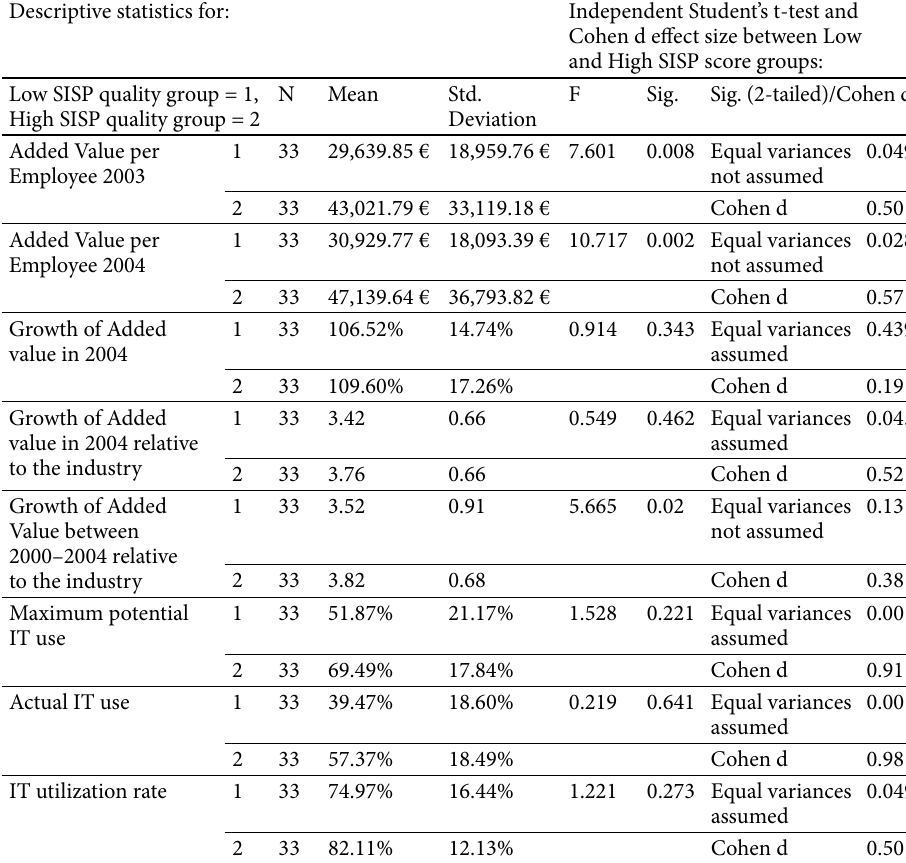
Table 1. Basic descriptive statistics, Independent Student’s t-tests and Cohen’s d effect sizes between low and high SISP quality groups of enterprises for variables of economic performance of IT investments and variables of the utilization of the deployed